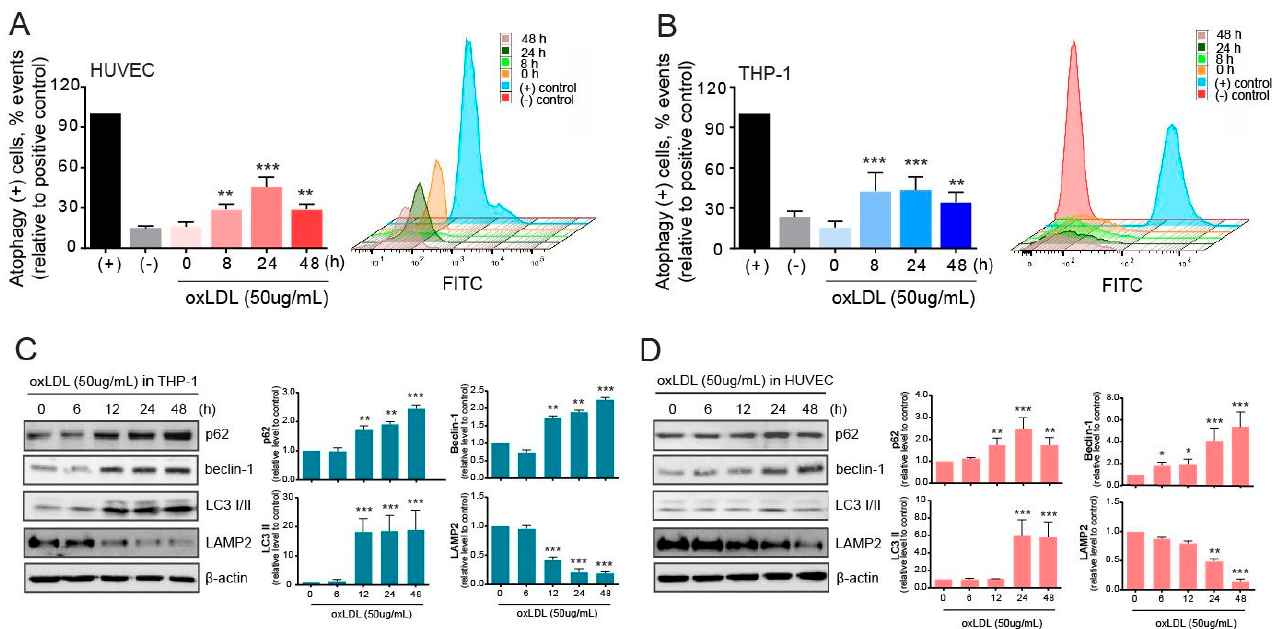
Figure 2. Initiation of autophagy in co-cultured macrophages and endothelial cells upon oxLDL exposure. ( A ) After oxLDL treatment, autophagy in HUVECs was evaluated using the CYTO-ID kit and presented as relative values to the positive control. ( B ) Autophagy in THP-1 cells after oxLDL administration was evaluated using the CYTO-ID kit and presented as relative values to the positive control. ( C ) Western blot analysis in THP-1 cells was used in the evaluation of autophagy-related molecules. ( D ) Autophagy-related molecules were evaluated by western blotting in HUVECs. *, p < 0.05; **, p < 0.001, ***, p < 0.0001.